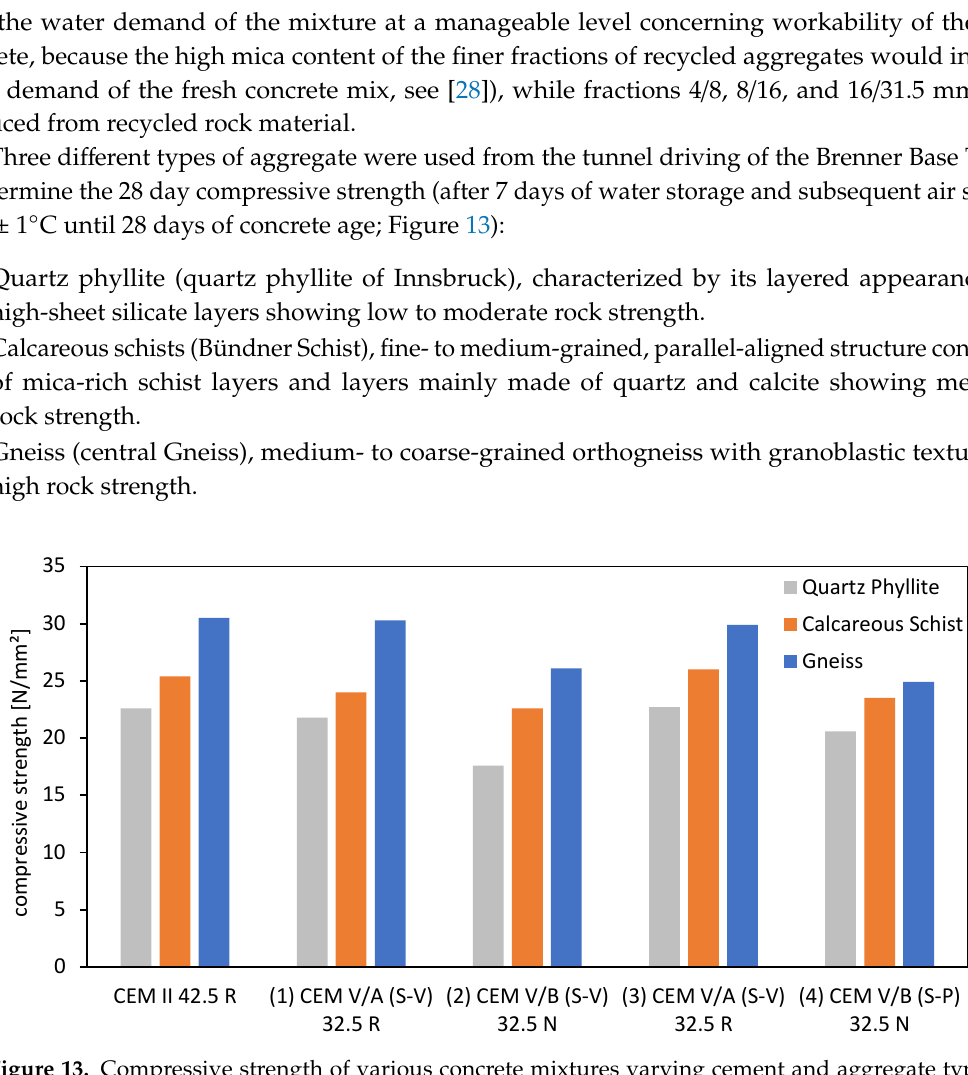
Figure 13. Compressive strength of various concrete mixtures varying cement and aggregate type (each value as mean value of 3 individual tests) after 28 days.